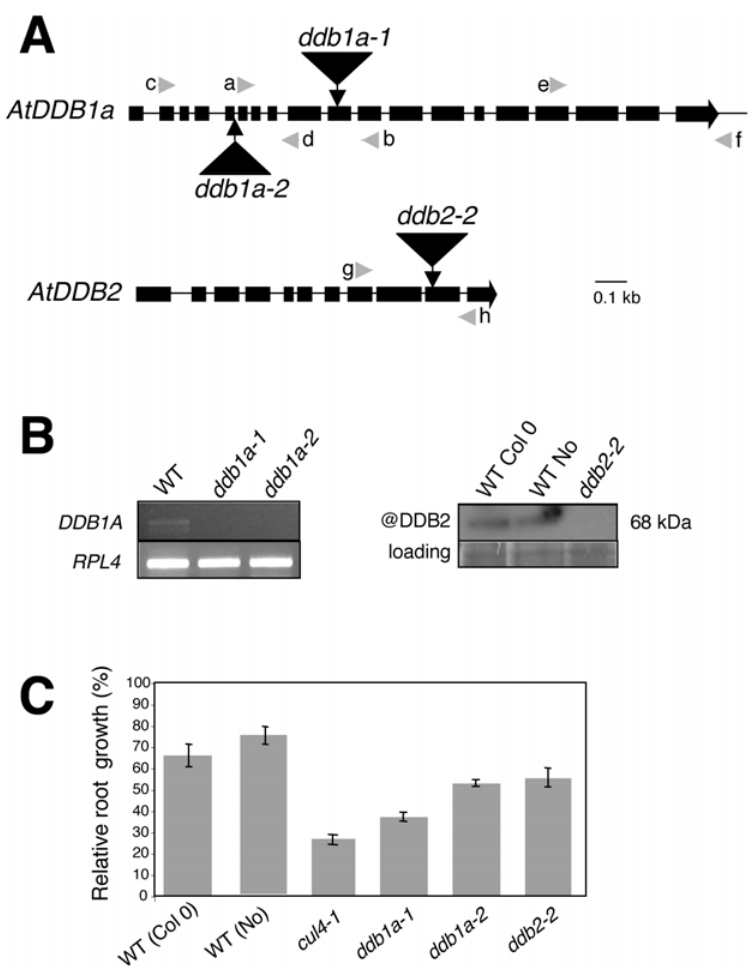
Figure 1. cul4 , ddb1a and ddb2 insertion mutant lines exhibit hypersensitivity to UV-C. (A) Genomic organization of the DDB1A and DDB2 loci. T-DNAs are inserted in the 10 th exon (black boxes) in the ddb1a-1 and in the 5 th intron (black line) in ddb1a-2 mutant plants. Primers a–b, c–d and LBb1 were used for genotyping ddb1a-1 and ddb1a-2, respectively. In the ddb2-2 , the transposon is inserted in the 10 th exon (black boxes). Primers h– g and Ds5-2a were used for genotyping (see supplemental material for details). (B) Molecular characterisation of DDB1A- and DDB2-mutant plants. RT-PCR analyses were performed for DDB1A expression in WT and the insertional mutants ddb1a-1 and ddb1a-2 using the specific e–f primers. RPL4 primers were used as a control (See supplemental material for details). Immuno-detection of DDB2 protein in two different WT Arabidopsis thaliana ecotypes (Columbia: Col0 and Nossen: No) and in the ddb2-2 insertional mutant. Coomassie blue staining was used as loading control. (C) Root- growth assay. One-week-old mutant ( cul4-1 , ddb1a-1 , ddb1a-2 , ddb2-2 ), and WT control plants were exposed to 600 J/m 2 of UV-C. Root growth was measured 24h following irradiation. Root growth was calculated relative to the corresponding untreated plants ( 6 SEM). Eight plants per replicate were used and experiments were performed in triplicates. For all mutants p , 0.05, compared to WT plants (both ecotypes).